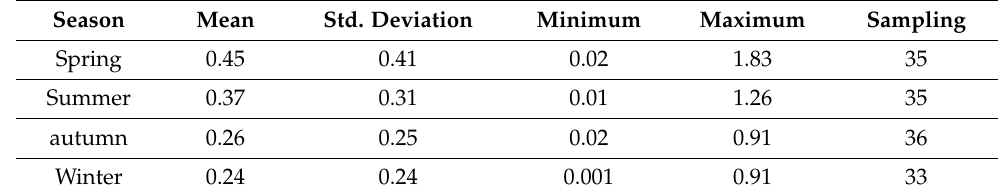
Table 3. Seasonal characteristics of NH 3 concentrations at NPK fertilizer production plants. Unit: ppm.